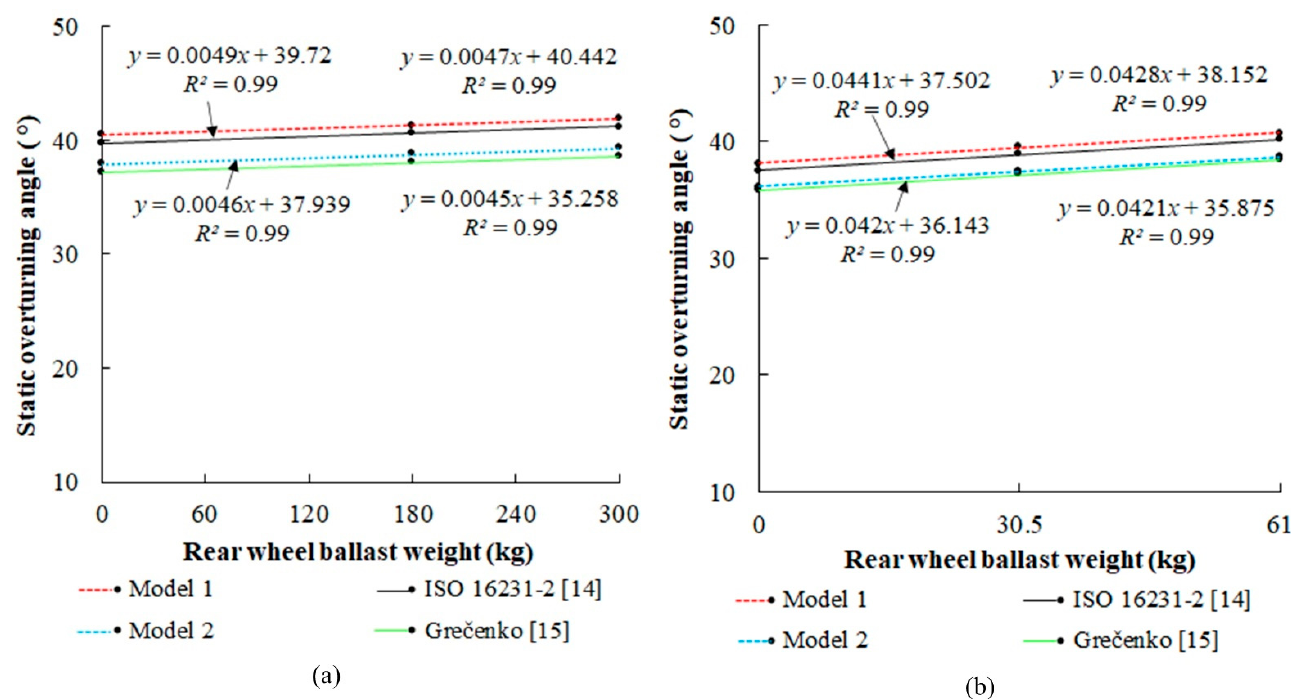
Figure 12. Comparison of [14,15], Model 1, and Model 2 at high overall tire width: ( a ) Universal tractor; ( b ) Subcompact tractor.